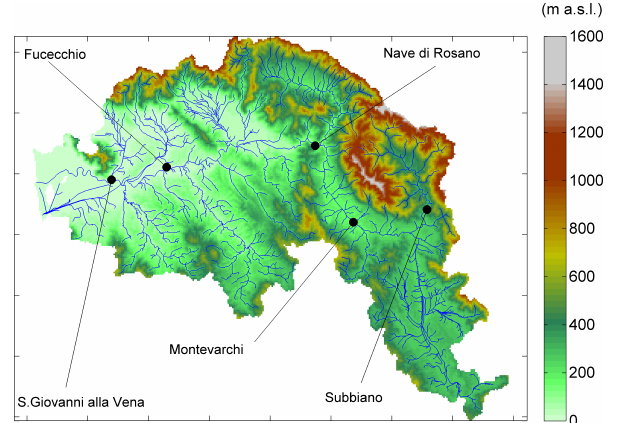
Figure 1. DEM and river network of Arno basin used in the sim- ulations. Black circles indicate measurement stations available for experiments of flow data